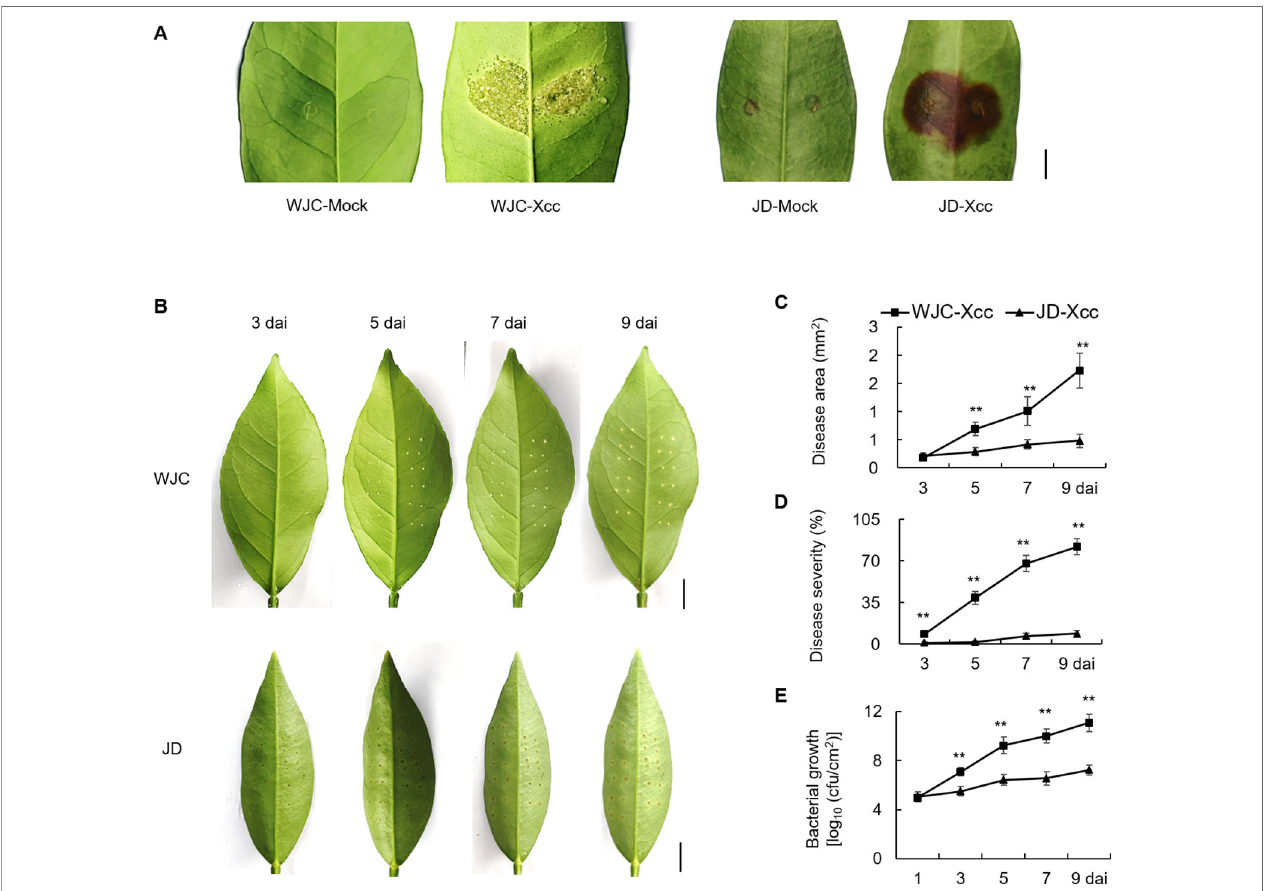
FIGURE 1 | Canker disease resistance assay of Wanjincheng orange and Jindan. (A) Citrus canker symptoms on leaves of Wanjincheng orange and Jindan after in vitro inoculation with canker pathogen Xcc by injection. Scale bar = 0.5 cm. Fully expanded citrus leaves were injected with 5 × 10 5 cfu/mL Xcc suspensions, and samples receiving a water treatment were used as blank controls. Photographs were taken at 10 days after treatment. (B) Citrus canker symptoms on different citrus leaves after inoculation with Xcc by pinprick. Scale bars = 1 cm. (C) Disease area on leaves of Wanjincheng orange and Jindan after inoculation. (D) Statistics of disease severity for Wanjincheng orange and Jindan leaves after inoculation. (E) Growth of Xcc in leaves of Wanjincheng orange and Jindan plants. Fully expanded citrus leaves were challenged with Xcc. 1 µL of bacterial suspension (5 × 10 5 cfu/mL) was applied to each puncture site made with a pin (0.5 mm in diameter). Disease development and symptoms were observed every day after inoculation. The photographs were taken at 3, 5, 7, and 9 days after inoculation. Data represent the averages ± standard deviations (SDs) from three biological repeats, and nine independent leaves were observed for each replicate experiments. Statistical analyses were performed with two-tailed Student ’ s t -test to compare data from WJC-Xcc and JD-Xcc of the same time point (**, P < 0.01). WJC, Wanjincheng orange; JD, Jindan; Xcc, Xanthomonas citri ssp. citri ; cfu, colony-forming units; dai, days after